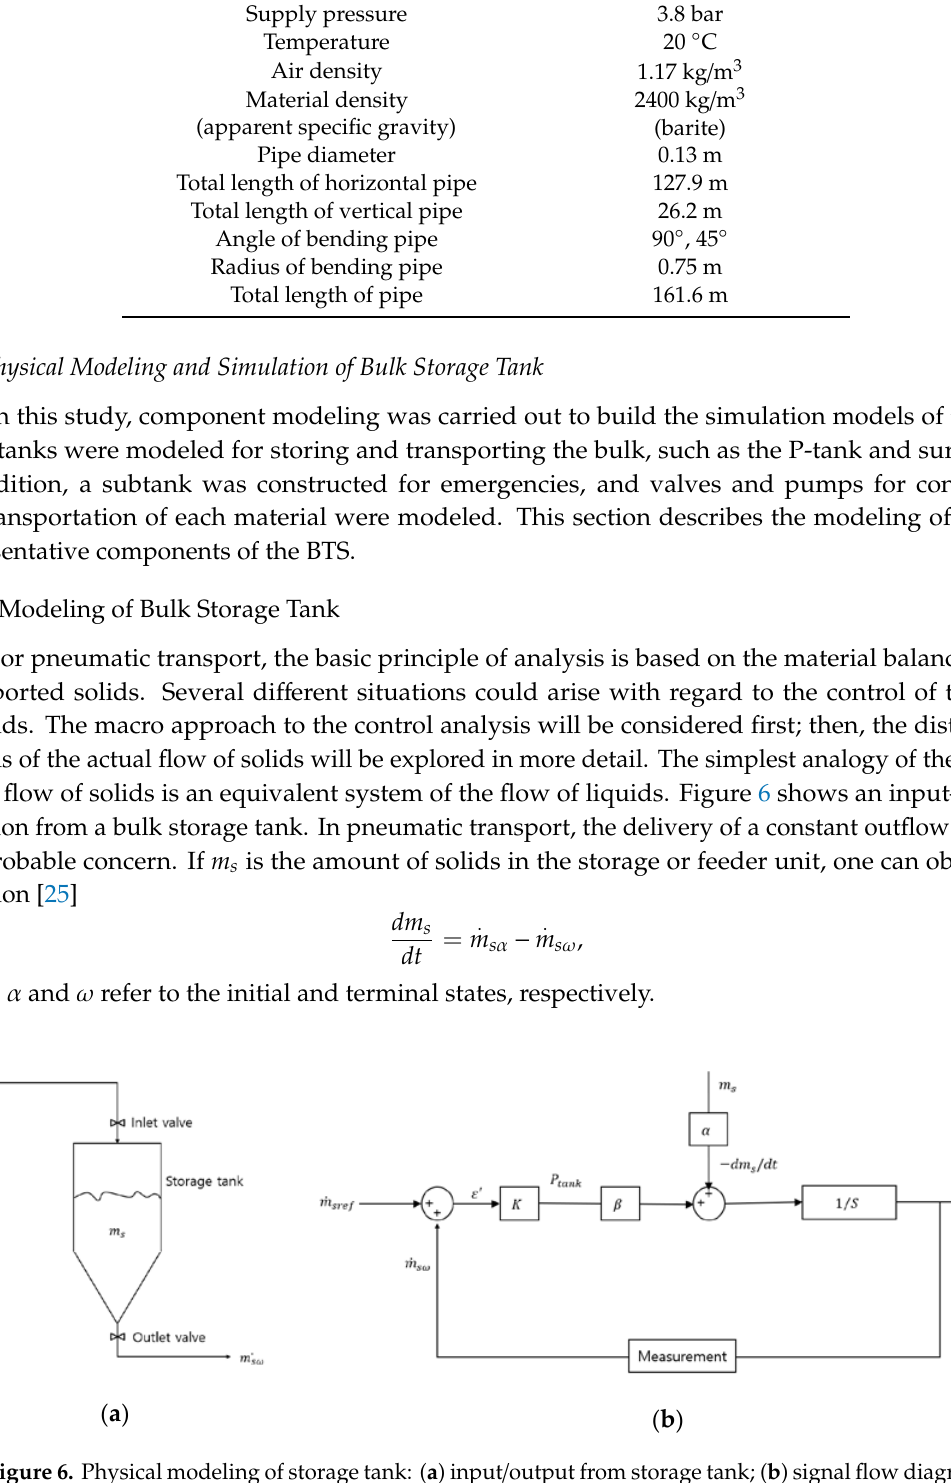
Figure 6. Physical modeling of storage tank: ( a ) input/output from storage tank; ( b ) signal flow diagram for storage tank.